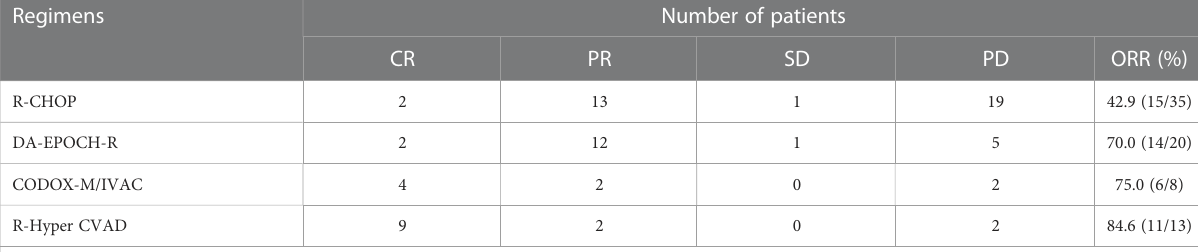
TABLE 3 Responses to fi rst-line